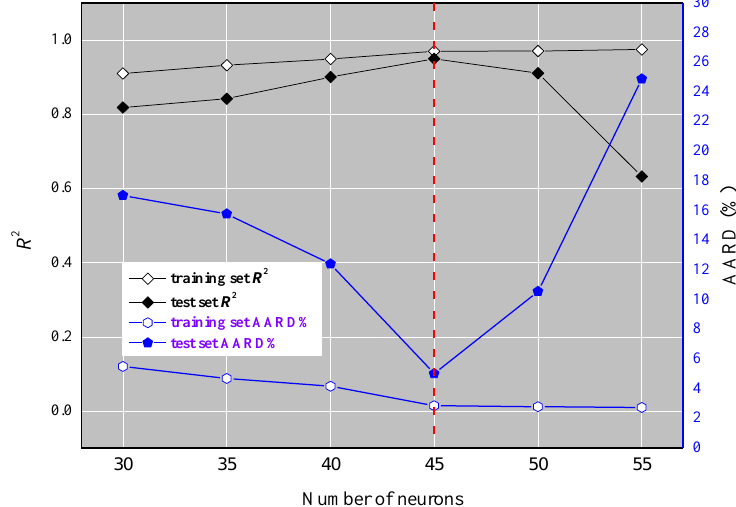
Figure 5. The R 2 and average absolute relative deviation (AARD%) versus the parameter number for the ELM) model.